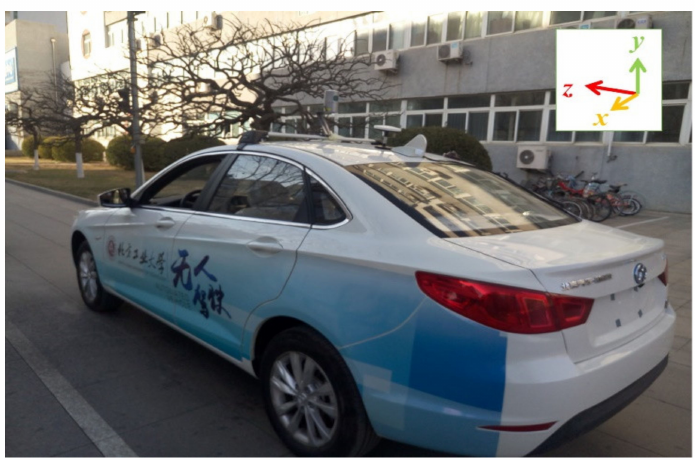
Figure 5. Unmanned vehicle carried with LiDAR